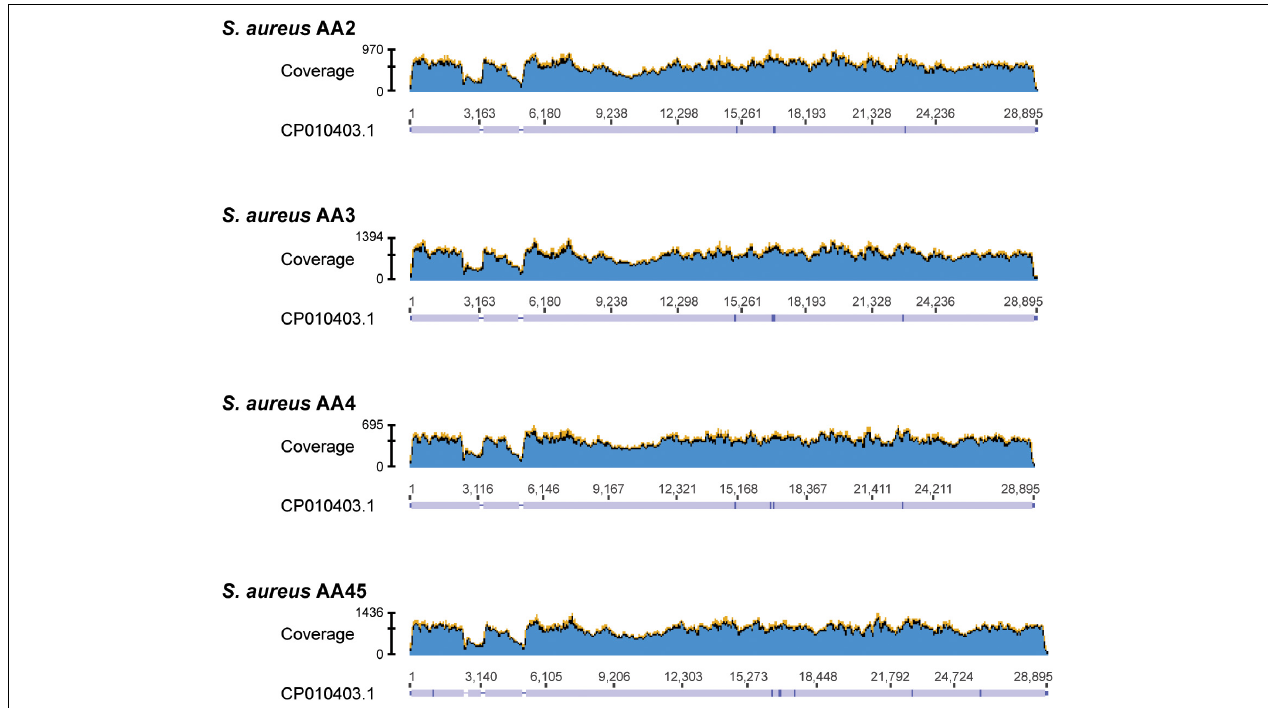
FIGURE 1 | Read coverage maps for the 4 S. aureus strains containing contigs showing homology to plasmid pGR2A (CP010403.1). Raw reads from each of the 4 strains were mapped to the pGR2A sequence and their coverage is shown in the graphs. Below each graph, the consensus sequence is shown. Regions covered appear in lavender. Breaks in this coverage (lavender bar) indicates regions where no reads